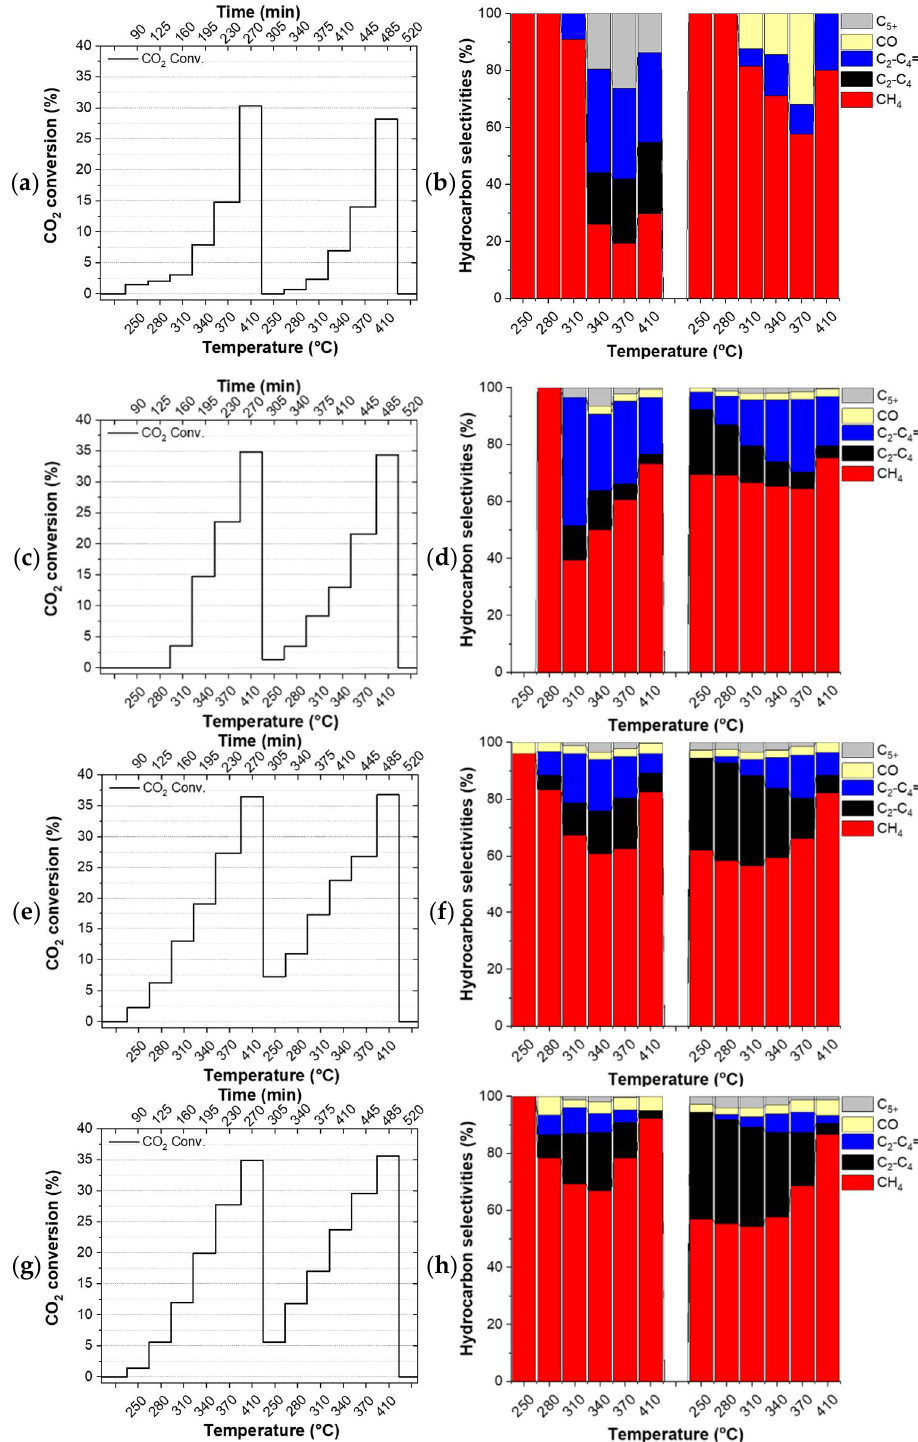
Figure 2. Hydrogenation of CO 2 . CO 2 conversion and selectivities by ( a , b ) FeO x , ( c , d ) 1%-Cu/FeO x , ( e , f ) 3%-Cu/FeO x , ( g , h ) 5%-Cu/FeO x . A total of 200 mg of catalyst and CO 2 /H 2 /He (1:5:4, total flow 25 mL/min).